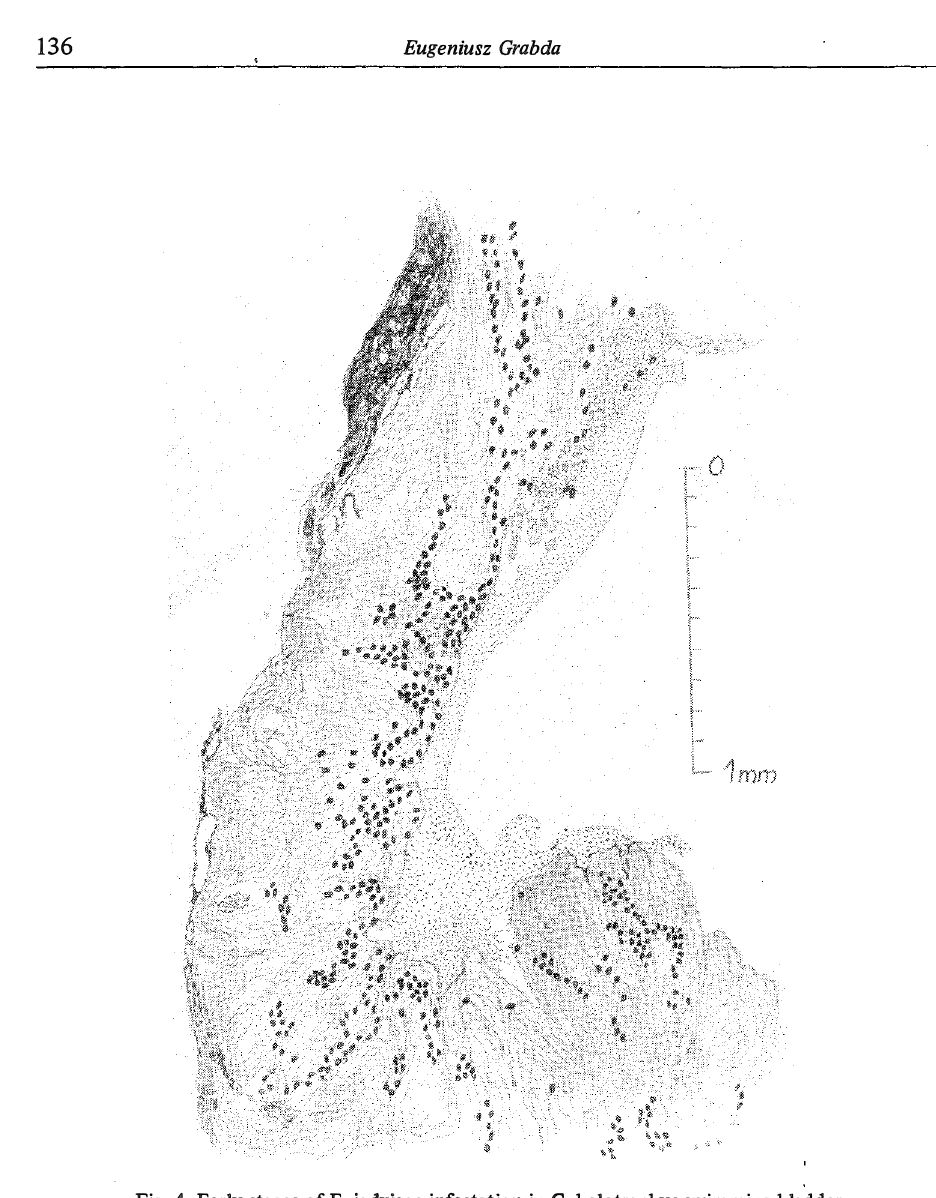
Fig. 4. Early stages of E. jadvigae infestation in C. holotrachys swimming